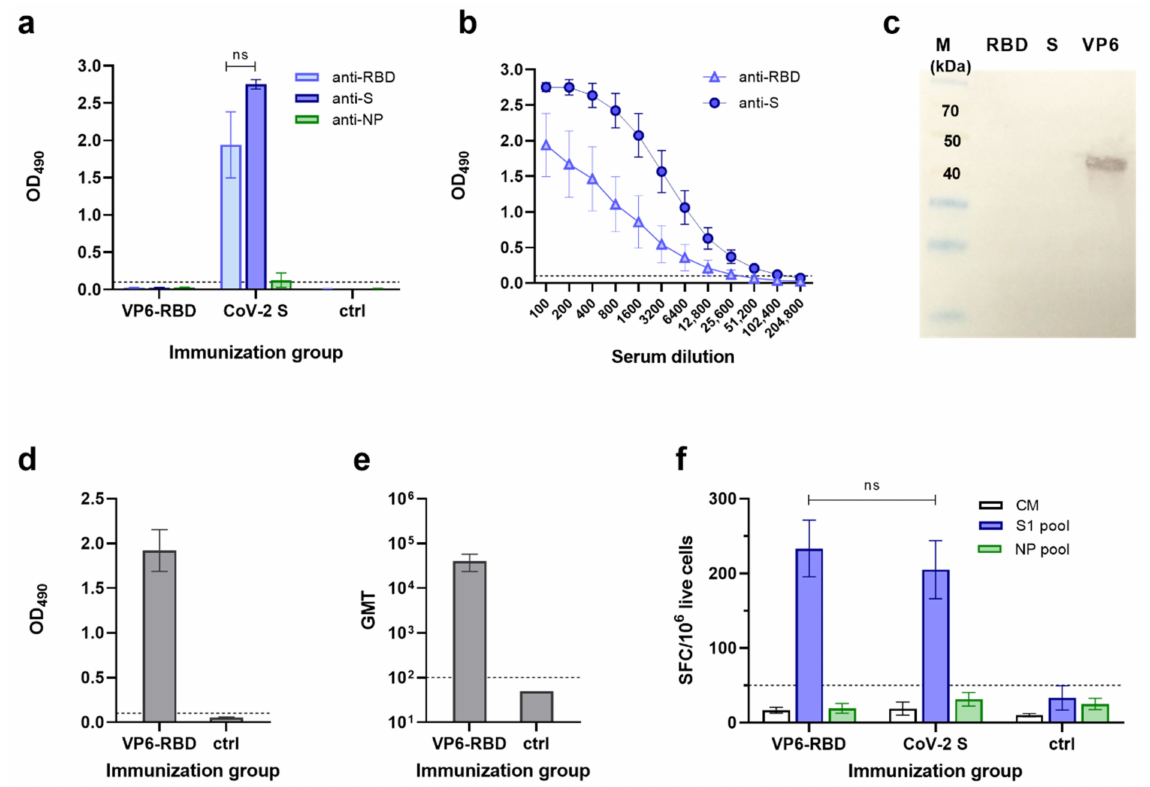
Figure 2. SARS-CoV-2 and VP6-specific antibody and T cell responses. Serum IgG antibody responses in mice following immunization with VP6-SARS-CoV-2 receptor-binding domain (VP6-RBD) fusion protein (FP), SARS-CoV-2 Spike (CoV-2 S, a positive control), or carrier only (PBS, a negative control) were analyzed by antigen-specific ELISAs and/or Western blot. SARS-CoV-2 S, RBD, and nucleoprotein (NP)-specific IgG antibodies are shown, represented by mean optical density (OD) values with standard error of the mean (SEM) of sera diluted 1:100 ( a ) and serum titration curves of CoV-2 S immunized mice ( b ). VP6-RBD FP immune sera were further used as a pool of individual sera (1:100 dilution) to detect SARS-CoV-2 RBD, S, and VP6 (each 1 µ g/lane) proteins under denaturing conditions in a Western blot ( c ). Molecular weight marker (M) is shown with the respective molecular sizes (kDa). VP6-specific IgG responses of VP6-RBD FP immunized and control mice are illustrated by mean OD values with SEM ( d ) and geometric mean titer (GMT) with 95% confidence intervals ( e ). If the starting dilution resulted in an OD value below the set cutoff, the sample was given an arbitrary value half of the starting dilution (ctrl, ( e )). T cell responses of immunized and control mice splenocytes were analyzed by ELISPOT IFN- γ against SARS-CoV-2 S1 and NP (a negative control) peptide pool stimulation ( f ). Cell culture medium (CM) alone was used to determine background cytokine release. Mean IFN- γ spot-forming cells (SFC)/10 6 live splenocytes of duplicate wells with SEM are shown. Dashed horizontal lines in the panels represent the cutoff value for ELISA (( a , b , d , e ), mean OD 490 + 3 × SD and at least 0.1 OD of negative control mice) and ELISPOT (( f ), mean SFC/10 6 cells + 3 × SD of CM wells). Statistical significance was defined as p < 0.05 and hypothesis testing was two tailed. ns: not significant p